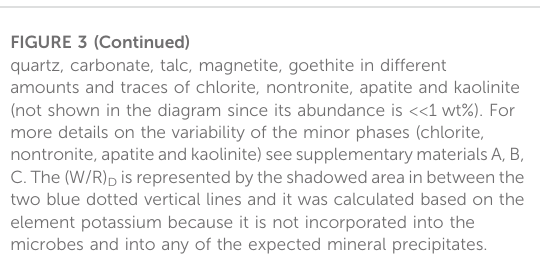
FIGURE 3 Secondary minerals predicted from the dissolution of the regolith simulant at 14 ° C and 2 bar under abiotic and biotic conditions. (A) variation of the pH in the abiotic model; (B) abiotic model where the pH was set as a free parameter; (C) biotic model where the pH was set at 7.0; (D) biotic model where the pH was set at 7.4. The diagrams show the formation of pyrite,